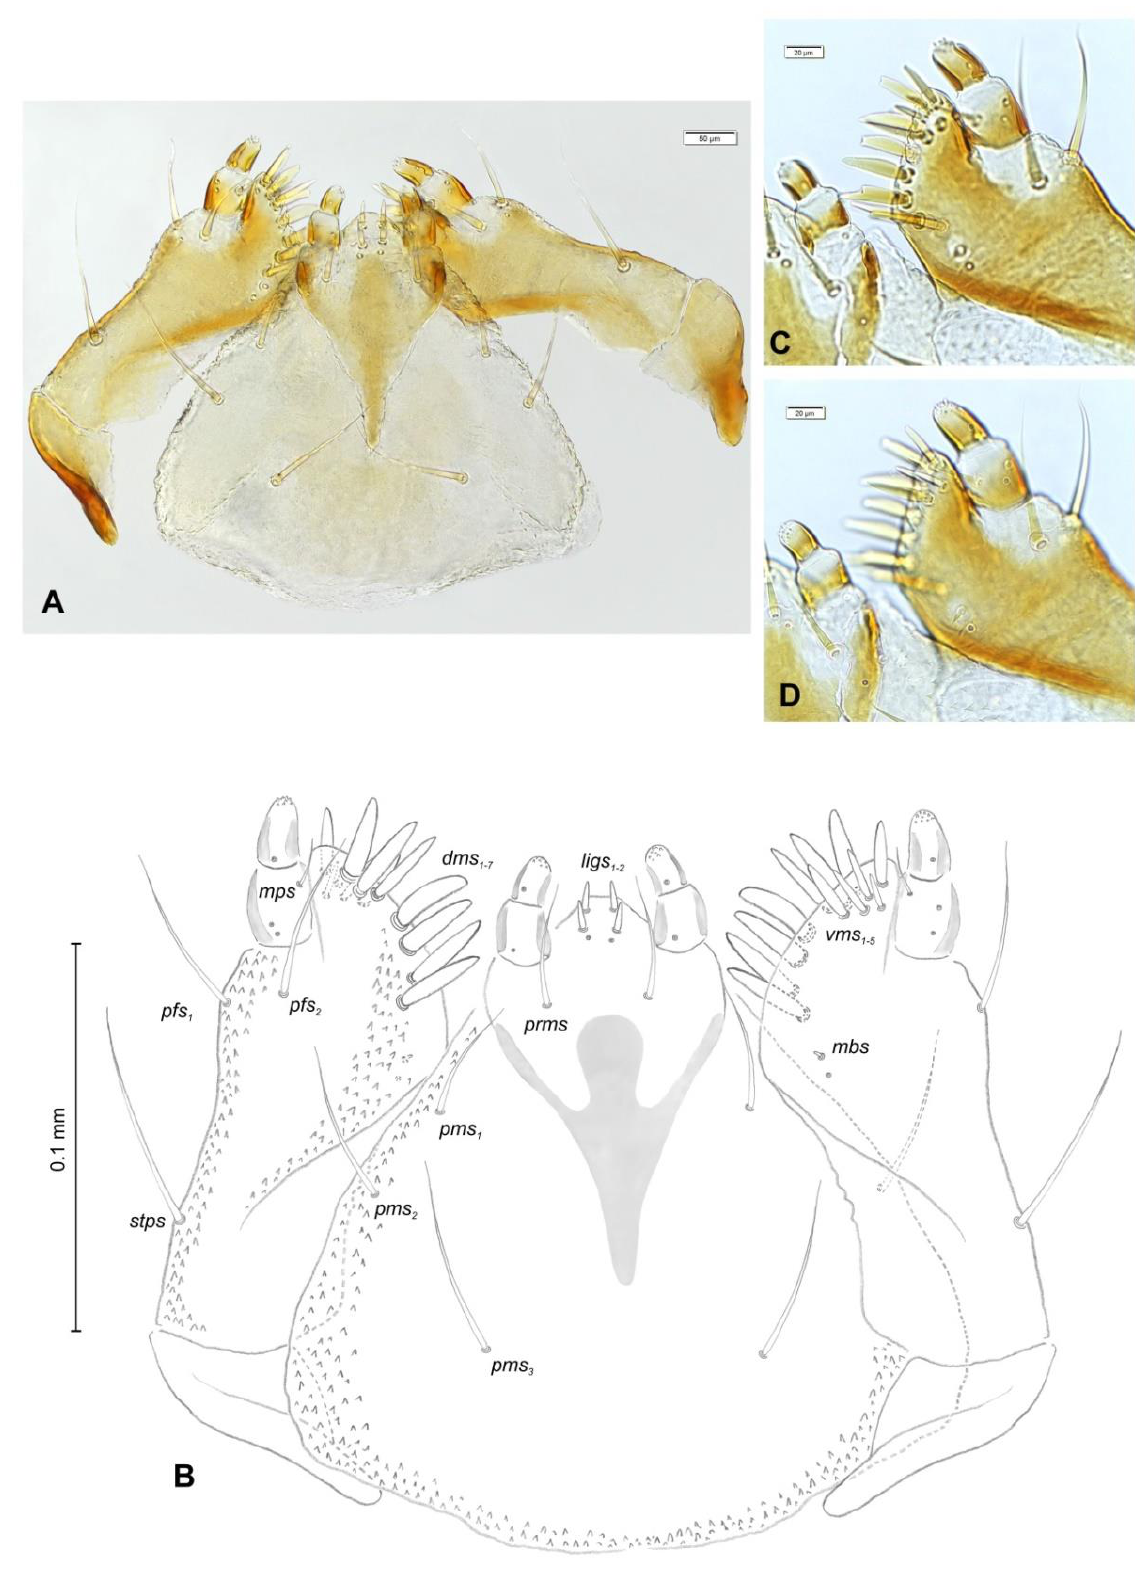
Figure 10. Euryommatus mariae mature larva, maxillolabial complex. ( A ) Maxillolabial complex, ventral view, photo; ( B ) maxillolabial complex, ventral view, scheme; ( C ) apical part of right maxilla, dorsal view; ( D ) apical part of right maxilla, ventral view, ( dms —dorsal malar, ligs —ligular, mbs —malar basiventral, mps —maxillary palp, pfs —palpiferal, prms —prelabial, pms —postlabial, stps —stipal, vms —ventral malar).